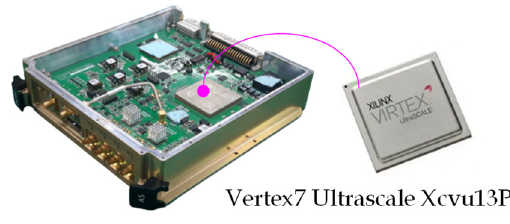
Figure 7. FPGA correlators.